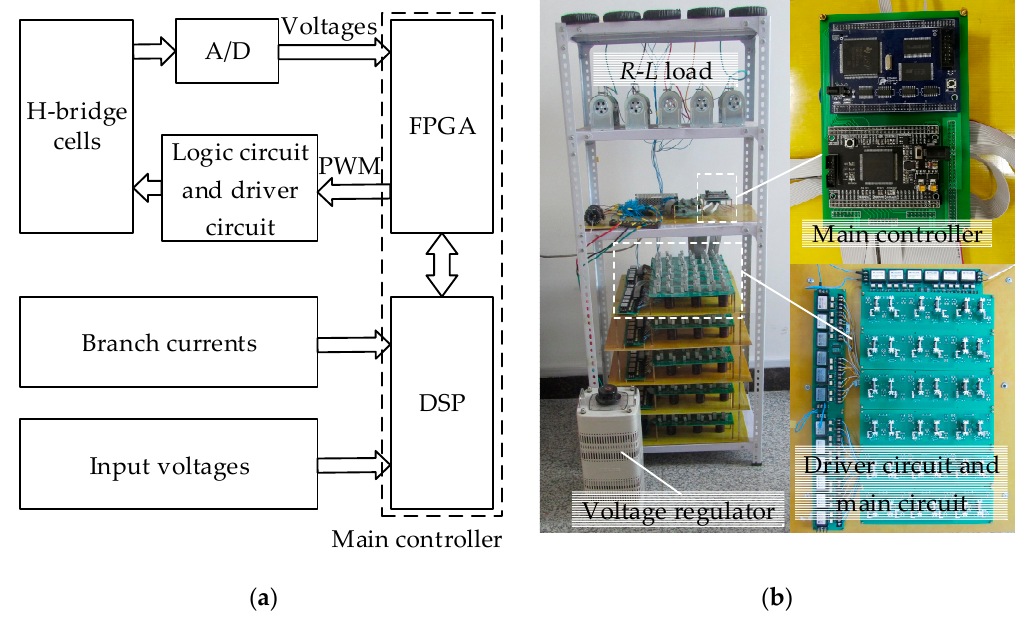
Figure 11. Configuration of experimental platform ( a ) system structure; ( b ) photos of experimental platform.